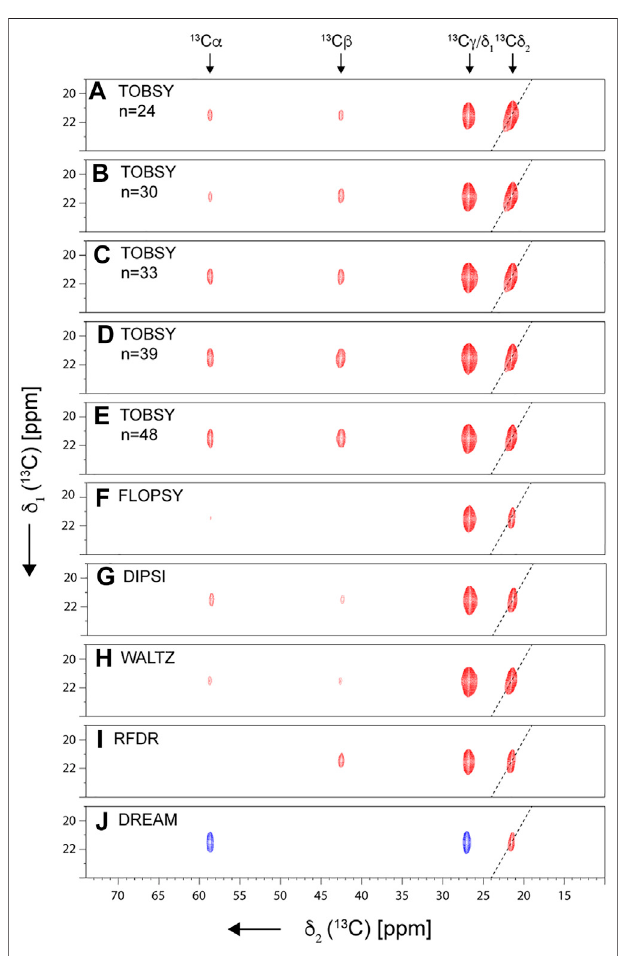
FIGURE 5 | Strips from 2D 13 C – 13 C spectra recorded for fMLF at ν R = 55.5 kHz on an 18.8-T spectrometer. Presented are diagonal and cross- peaks originating from Leu 13 C δ 1 magnetization (prior to 13 C mixing). Spectrum diagonal isindicated with adashed line. Spectra with amixing time optimal for C δ 1 → C α transfer are shown: 34.6, 32.0, 21.4, 25.3, and 36.3 ms for TOBSY C9 1 n , with n = 24, 30, 33, 39, and 48, respectively (A – E) ; 23.7, 27.4, and 20.7 for FLOPSY-16 (F) , DIPSI-3 (G) , and WALTZ-16 (H) , respectively; and 11.2 and 14 ms for RFDR ( ν 1 = 150 kHz) (I) and DREAM (J) ,